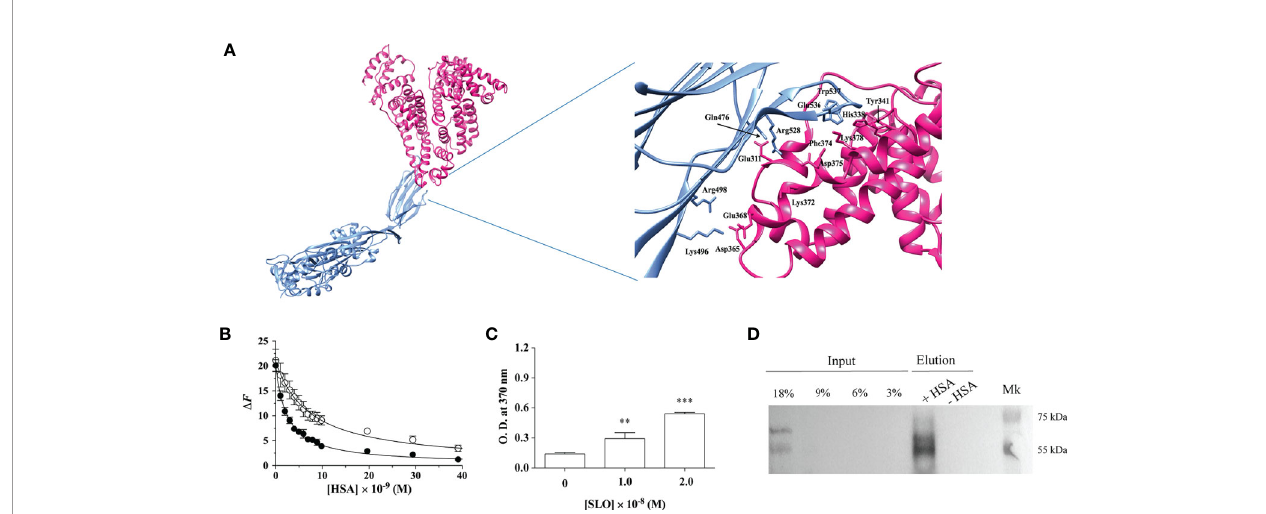
FIGURE 1 | HSA binds SLO toxin produced by Streptococcus pyogenes . (A) Molecular docking of SLO binding to HSA. Left: overall view of the putative complex between HSA (PDB ID: 1AO6) (deep pink) and SLO (PDB ID: 4HSC) (light blue) obtained by docking simulations. Right: residues involved in HSA-SLO interactions are highlighted. Images were drawn with the UCSF Chimera-package (35). (B) SLO binding to wt-HSA ( fi lled circles) and to L305A/F374A-HSA (open circles) evaluated by spectro fl uorimetric analysis. The continuous lines were calculated according to Eqn. 1 with the following parameters: wt-HSA - D F tot = 20.1 and K d = (2.5 ± 0.2)×10 − 9 M; and L305A/F374A-HSA - D F tot = 21.1 and K d = (7.3 ± 0.5)×10 − 9 M. Where not shown, the error bar is smaller than the symbol. (C) SLO binding to HSA evaluated by ELISA. Either 1.0×10 − 8 M or 2.0×10 − 8 M of activated SLO were added to HSA-coated wells, and the detection of HSA:SLO interaction was performed after incubation with anti-SLO antibody. Readings were performed using the TMB colorimetric substrate at 370 nm until reaction saturation. Microtiter wells coated with 100 m L of 1.6×10 − 7 M commercial HSA, without the subsequent addition of SLO, were used as a negative control. Results are representative of triplicates and are expressed as mean ± SD (One-way ANOVA, ** P < 0.01 and *** P < 0.001). (D) SLO binding to recombinant wt-HSA evaluated by magnetic beads assay. Activated SLO (2.9×10 − 7 M) was incubated with 4 m g of wt-HSA-conjugated (+) or unconjugated ( − ) beads. Thirty microliters of magnetic beads eluates were resolved on a 12.5% SDS-PAGE and SLO bound to HSA was detected by immunoblot using anti-SLO antibody. Different quantities of SLO (i.e., 45, 90, 135, and 270 ng corresponding to 3%, 6%, 9%, and 18% of 1.5 m g SLO) were loaded as inputs. Results show the presence of the bands corresponding to SLO in the